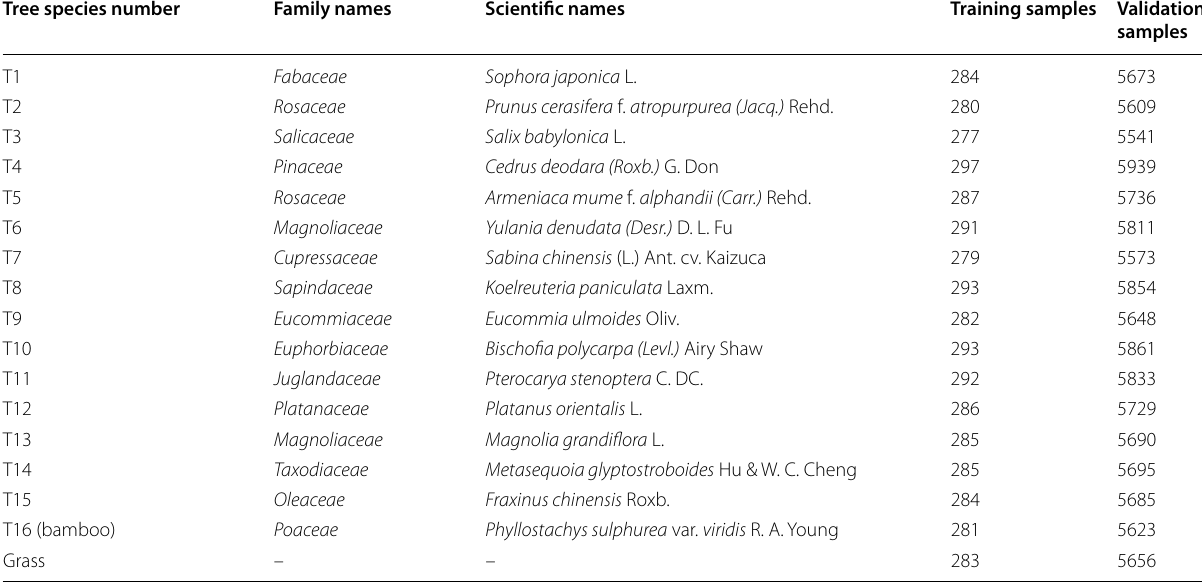
Table 2 Family, scientific names and numbers of pixels of the training and validation samples for tree species/bamboo classification Tree species